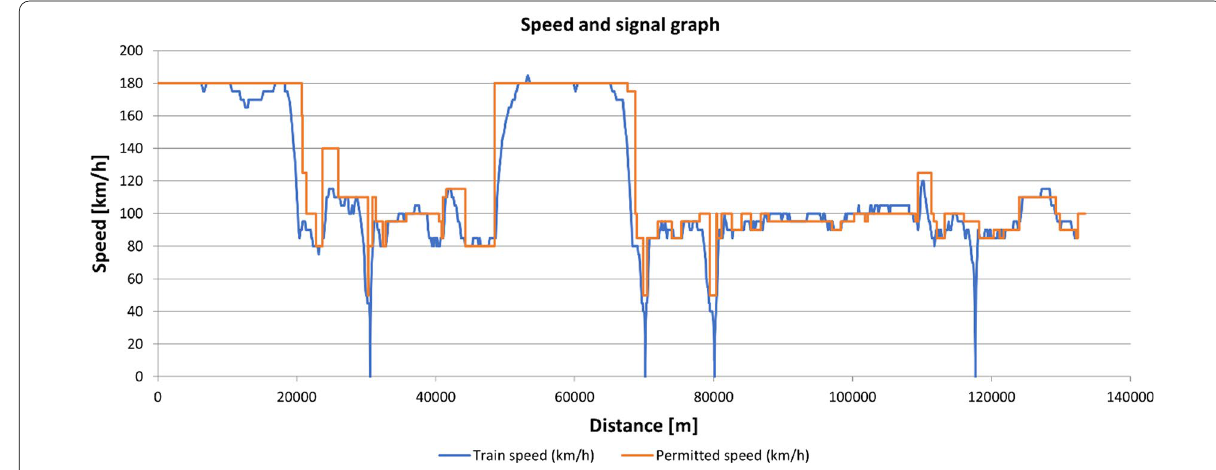
Fig. 4 Result from ETCS message extraction, speed-signal-distance